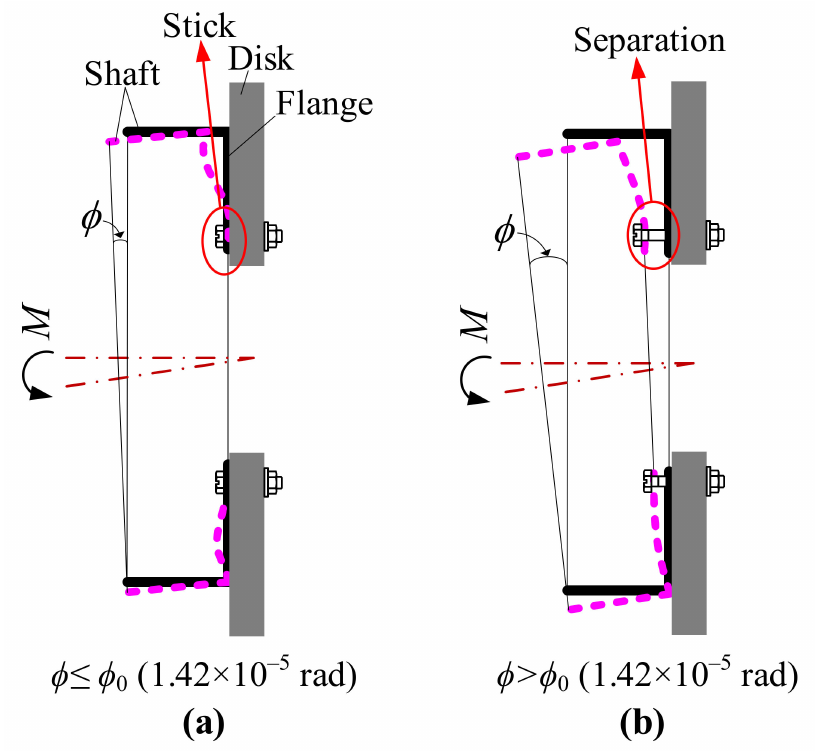
Figure 3. Schematic diagram for the deformation of the bolted joint under a bending moment: ( a ) stick state; ( b ) separation